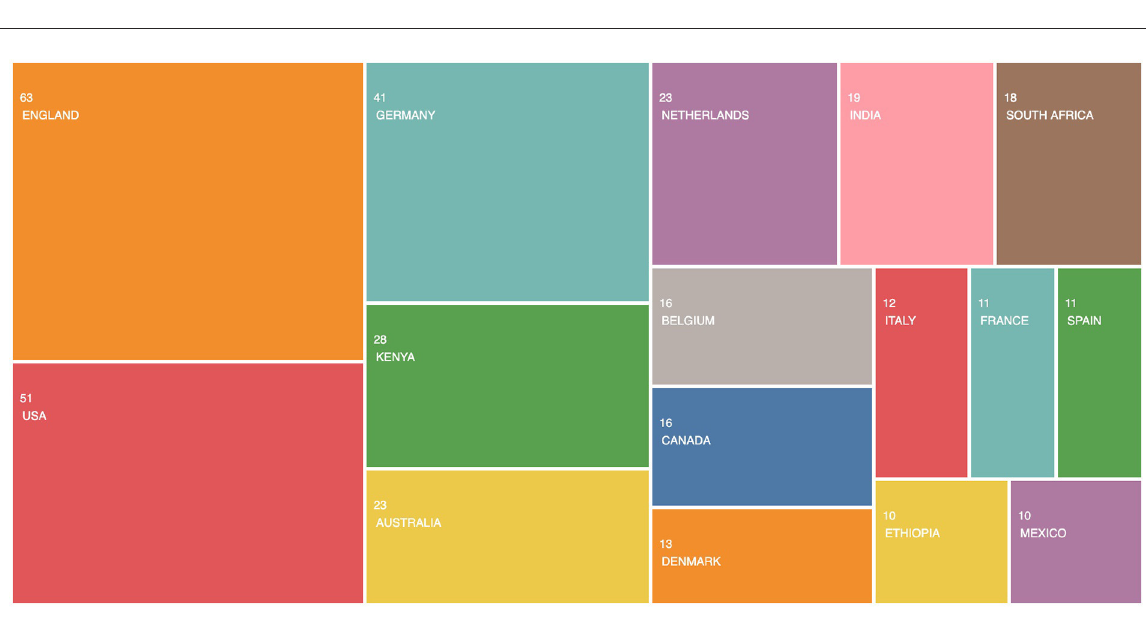
chains, (4) labor and upgrading in global agri-food value chains (Figure 6). Labor governance in global agri-food value chains through standards is the first research domain, which is focused on